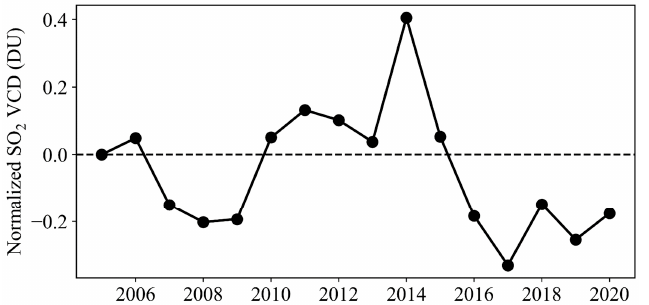
Figure 7. Relative change in SO 2 over East Africa, normalized based on the year 2005.